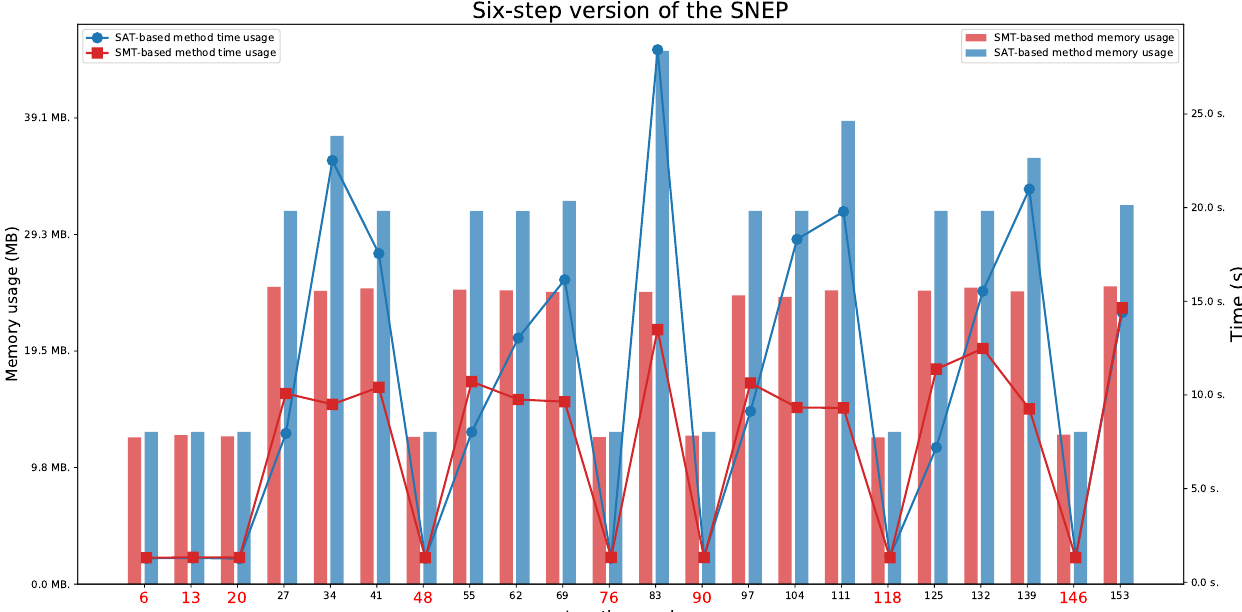
Figure 13. The six-step version of the SNEP: Time and memory usage for checking the last locations’ reachability in each execution automaton for lifetime values equal to 9. The reachable states are marked in